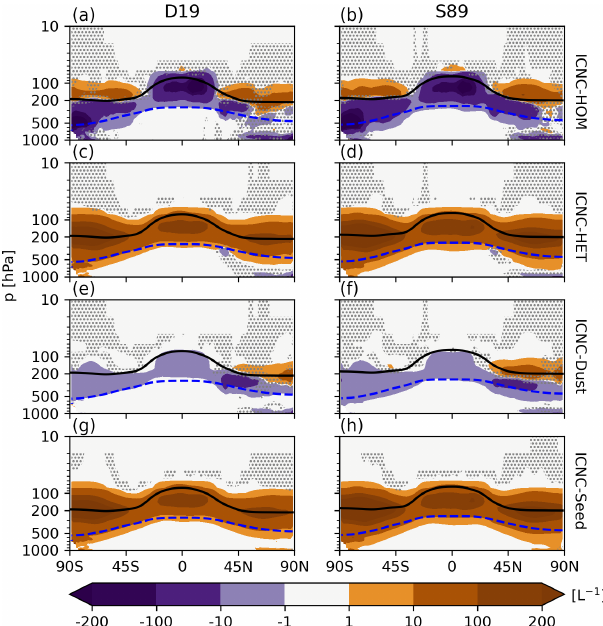
Figure 6. Five-year zonal mean in situ cirrus ice number tracer anomalies in L − 1 between the simulation with 100 seeding INP L − 1 for S i,seed = 1.05 and the respective unseeded reference case for both the D19 and S89 ice cloud fraction approaches. The anoma- lies include the in situ homogeneously nucleated ice number (a–b) , the in situ heterogeneous number (c–d) , the heterogeneously nucle- ated ice number formed on mineral dust particles (e–f) , and the het- erogeneously nucleated ice number formed on seeding particles (g– h) . The black line is the 5-year mean zonal mean WMO-defined tropopause height on pressure levels, and the blue dashed line is the 238K temperature contour. The stippling in the difference plots shows insignificant data points on the 95% confidence level accord- ing to the independent t test controlled by the false discovery rate